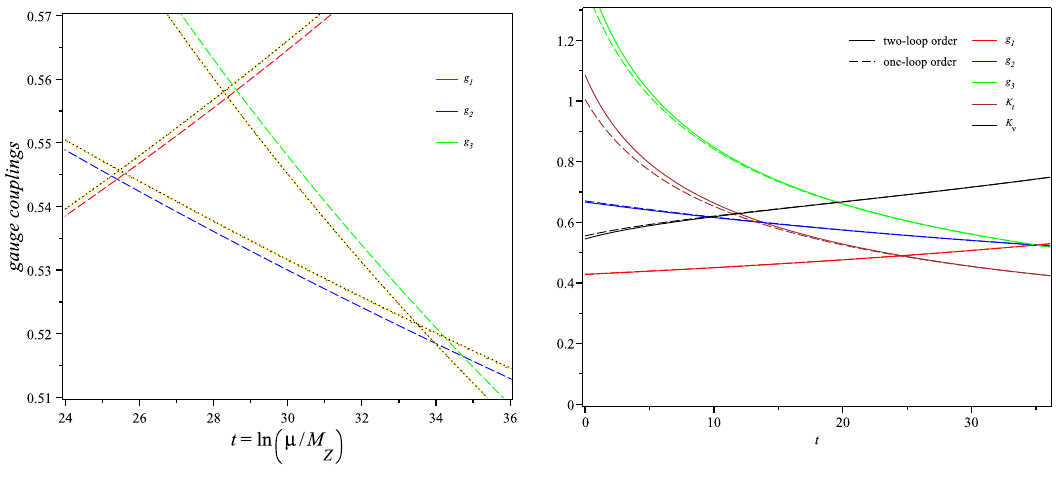
Figure 1 . The behavior of gauge couplings at the unification scale. Dashed lines are indicating the evolution of standard model couplings up to one-loop corrections. Yellow solid lines show the situation is slightly better when two-loop corrections are also taken into account. The black dotted lines are for RG equations up to three loops for the standard model. The black and yellow lines are so close that their separation cannot be distinguished in this diagram. This difference is from the same order of errors that experimental uncertainties create when we run the equations upward. In all cases, the corrections coming from a real or complex scalar field added to the standard model is negligible. Red dotted lines have two-loop corrections of the complex scalar field, in the model described in section 2, and include three-loop corrections of all the other parameters. Yet again it matches with two-loop corrections suggesting that higher orders are not going to make the situation any better. The graph on the left compares one-loop RGEs with two-loop equations for gauge and Yukawa couplings when we start at the same points at high energies and follow them toward experimental values. Again adding a singlet doesn’t creates meaningful